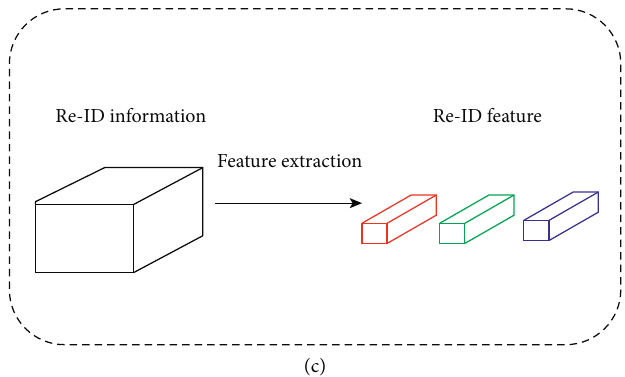
Figure 4: Model architecture. (a) Design concept. (b) Object detector. (c) Association